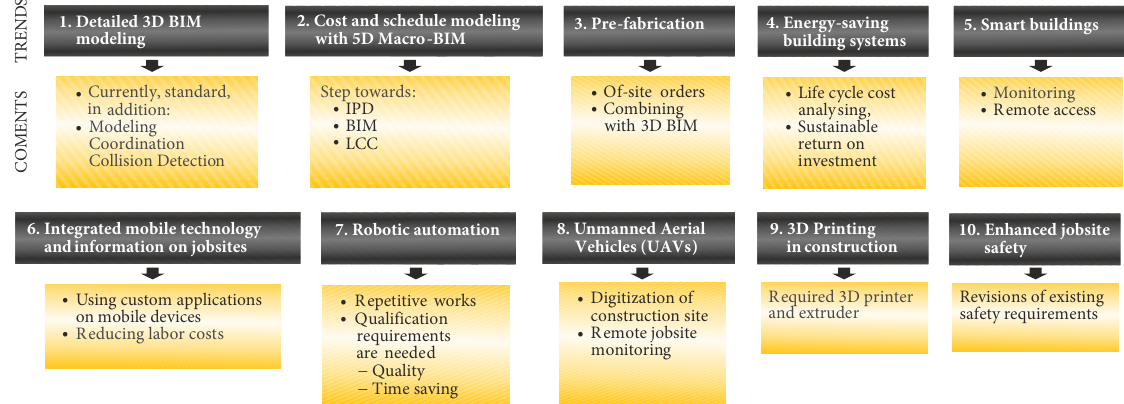
Figure 1. Ten construction trends shaping the industry in 2016 and